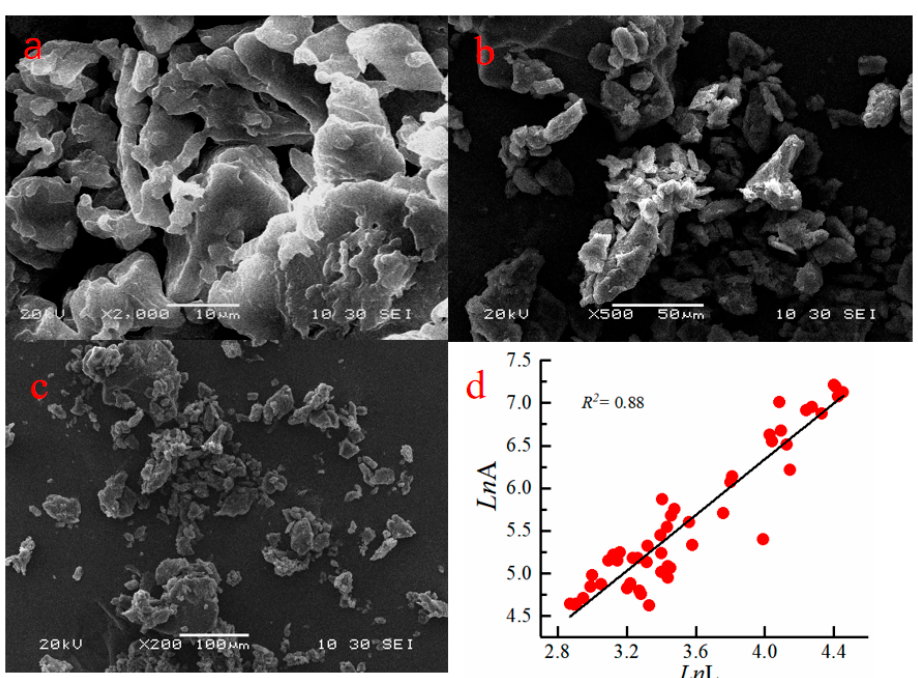
Figure 4. SEM pictures and the relationship between lnL and lnA of CTS-GSH. ( a ) Scanning electron microscope at 2000× magnification, ( b ) Scanning electron microscope at 500× magnification, ( c ) Scanning electron microscope at 200× magnification, ( d ) Linear correlation between LnL and LnA.